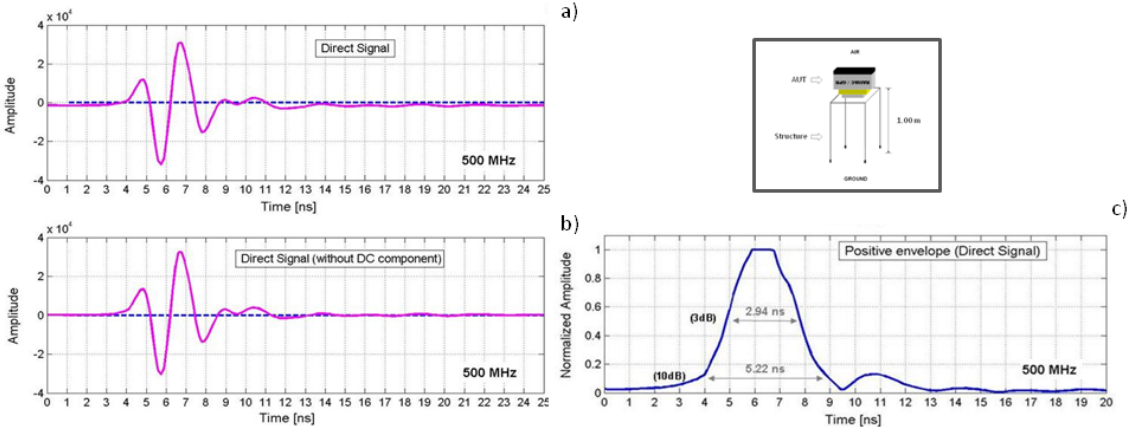
Figure 5. Direct Signal between dipoles obtained for the AUT. (a) Recorded A-Scan. (b) Recorded A-Scan without DC component. (c) Positive envelope of the signal